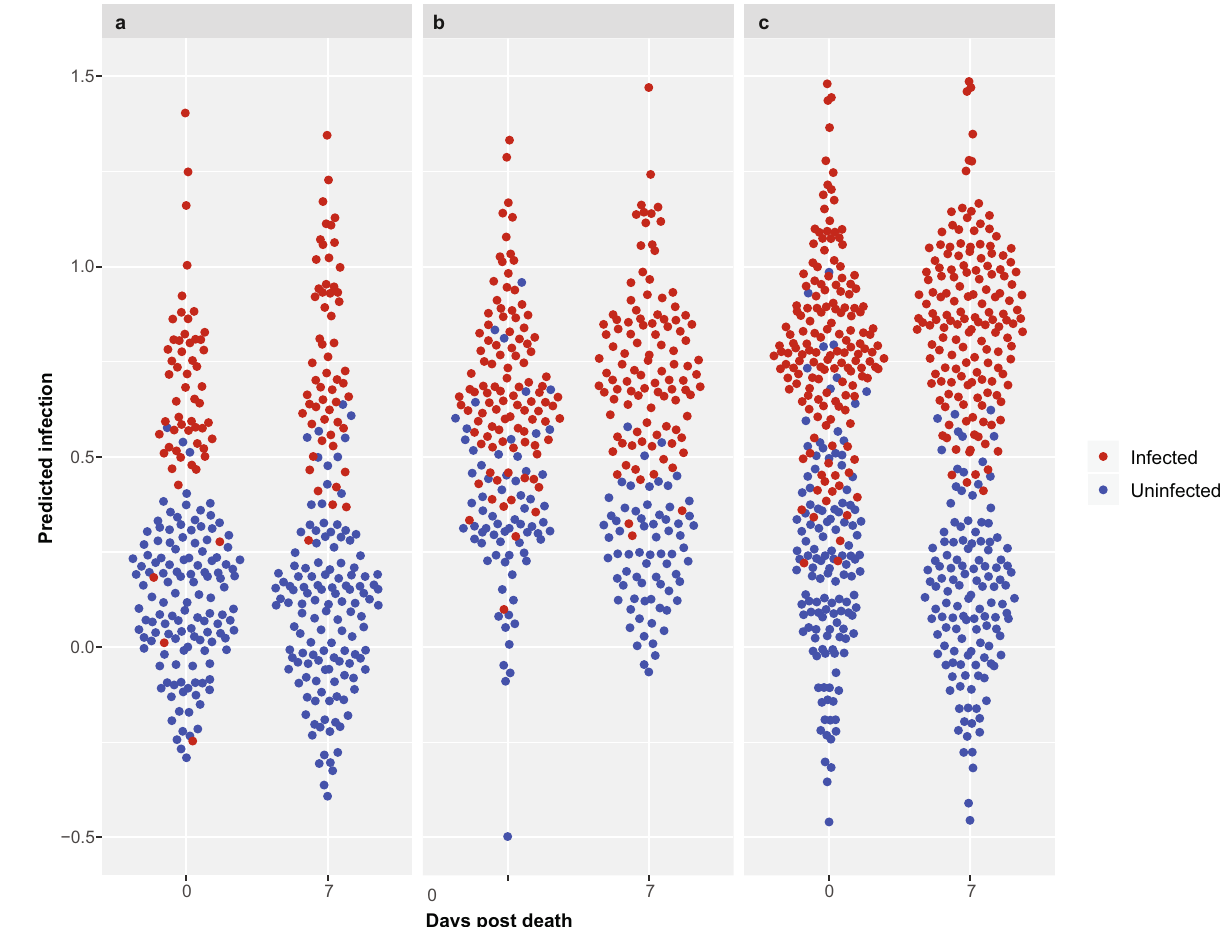
Fig. 4 Prediction scores of uninfected and uninfected mosquitoes for 0 days post death and 7 days post death. Infection scores are shown for CHIKV ( a ), Wolbachia ( b ), and ZIKV ( c ), and each dot represents one individual. The Y -axis represents the prediction scores on a continuous scale prior to categorizing into >0.5 (predicted infected) and ≤ 0.5 (predicted